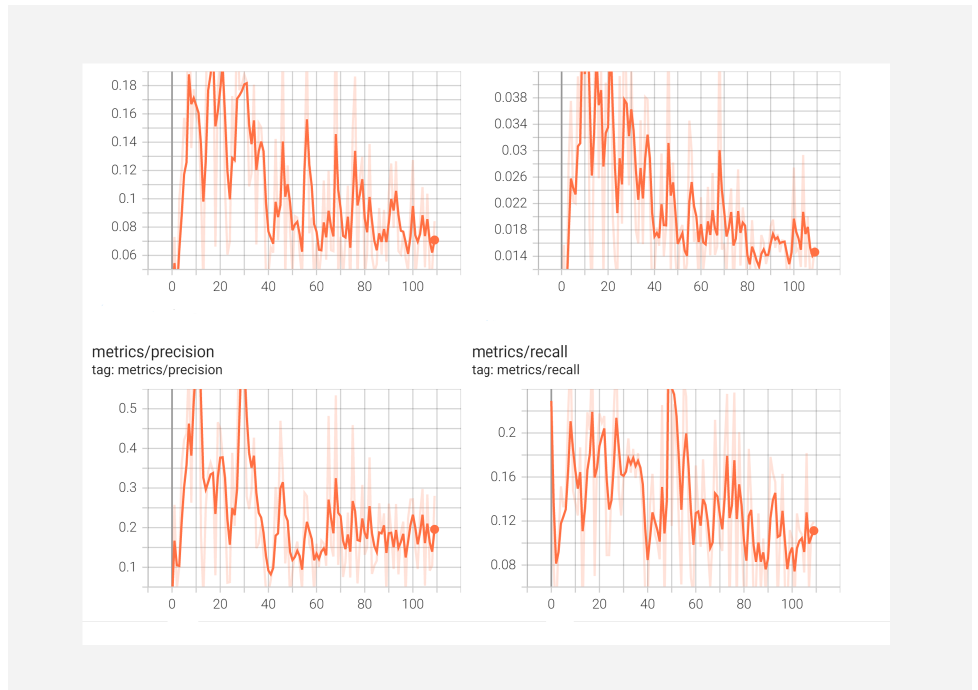
Figure 20. YOLOv5: mAP precision, and recall for training data of 1000